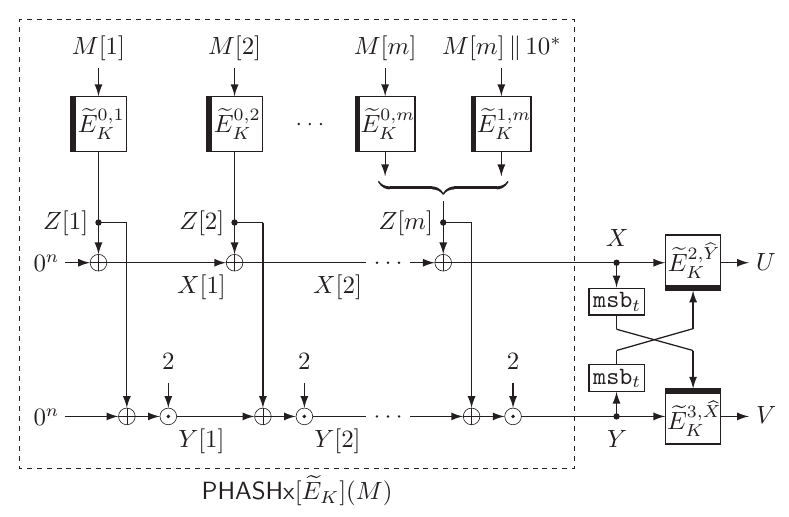
Figure 2: Illustration of PMAC2x. If | M [ m ] | = n , then we let Z [ m ] ← e E 0 ,m